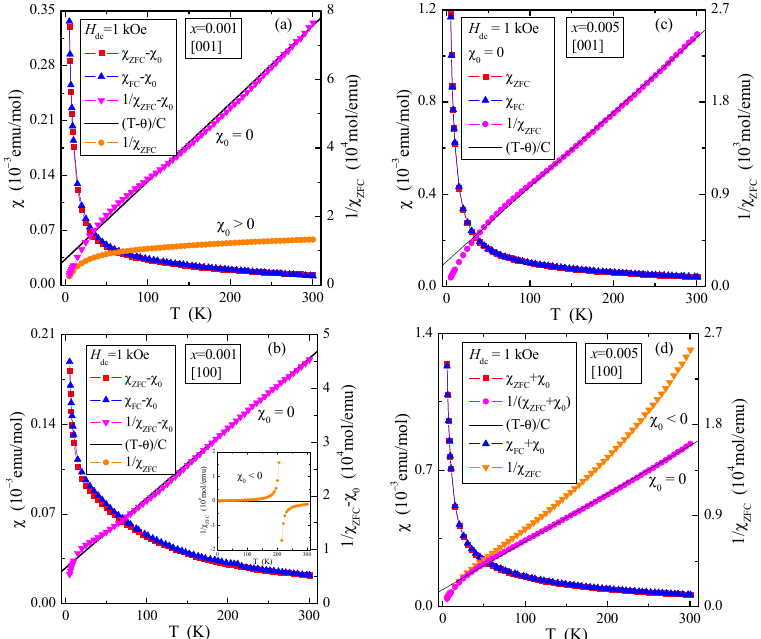
Figure 4. Magnetic susceptibility χ ZFC − χ 0 , χ FC − χ 0 , 1/ ( χ ZFC − χ 0 ) , (T − θ )/C and 1/ χ ZFC vs. temperature T of PNMWO single crystals: ( a ) x = 0.001 and [001], ( b ) x = 0.001 and [100]. Inset: χ ZFC (T) without 0 correction, ( c ) x = 0.005 and [001], ( d ) x = 0.005 and [100], recorded at H dc = 1 Table 2. Electrical parameters of PNMWO single crystals.